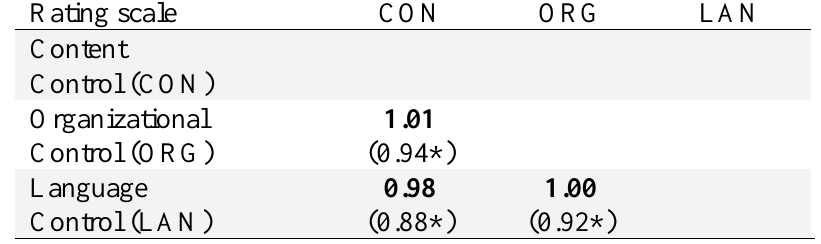
D-study Universe score correlations and Pearson product-moment correlations among the Three analytic rating scales** (2 tasks, 2